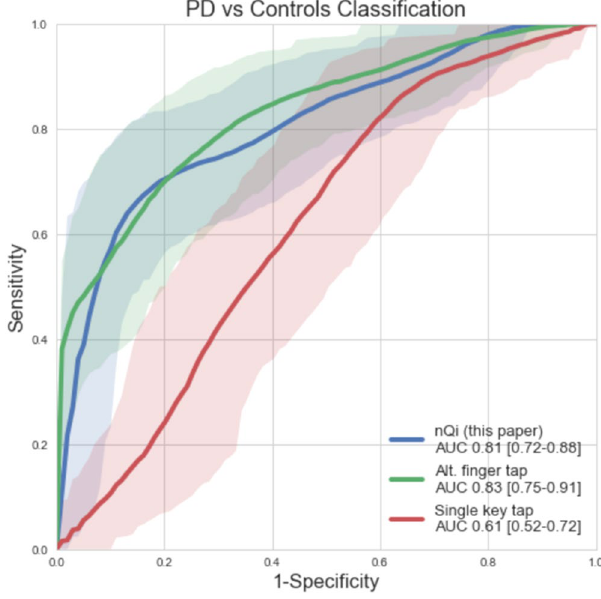
Figure 1. Comparison of receivers operating characteristic (ROC) curves showing the classification performance of nQi (main contribution of this paper), alternating finger tapping and single key tapping on the combined dataset of 42 PD subjects and 43 controls. The shadowed areas represent the 95% confidence intervals. In the legend, the area under the ROC curve (AUC) and the 95% confidence intervals and are shown (see Table 1 for more details). The nQi score shows comparable performance in to alternating finger tapping (p = 0.699) and superior to single key tapping (p = 0.01). Alternating finger tapping and single key tapping are two quantitative measurements commonly used to evaluate motor impairment in PD studies. In our cohort, the former showed better performance than the latter (p = 0.004). The p-values have been computed with the DeLong’s test for correlated ROC curves, which test the null hypothesis that the AUCs of two ROC curves are statistically the